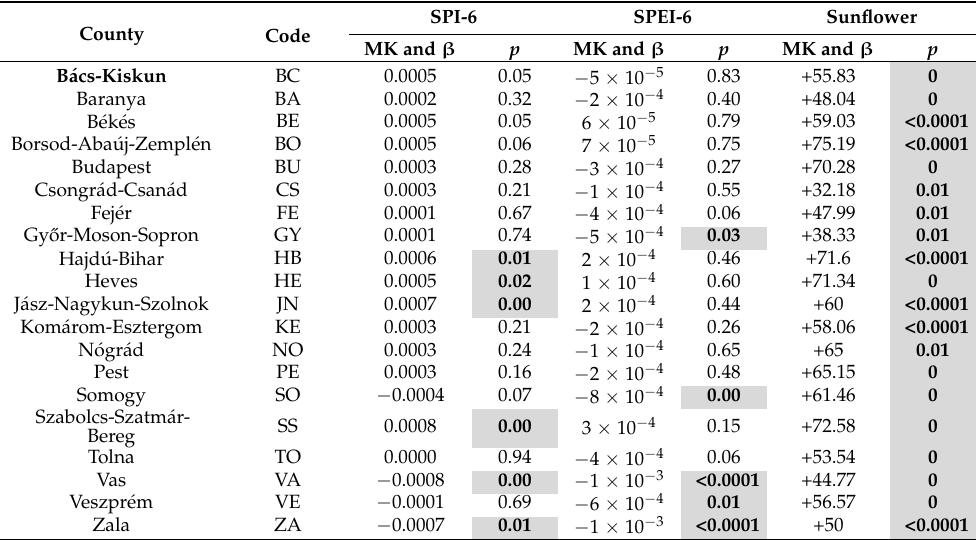
Table 5. Trends in Ag.D indices (SPI-6, SPEI-6) and sunflower production (kg/ha) across Hungary. County